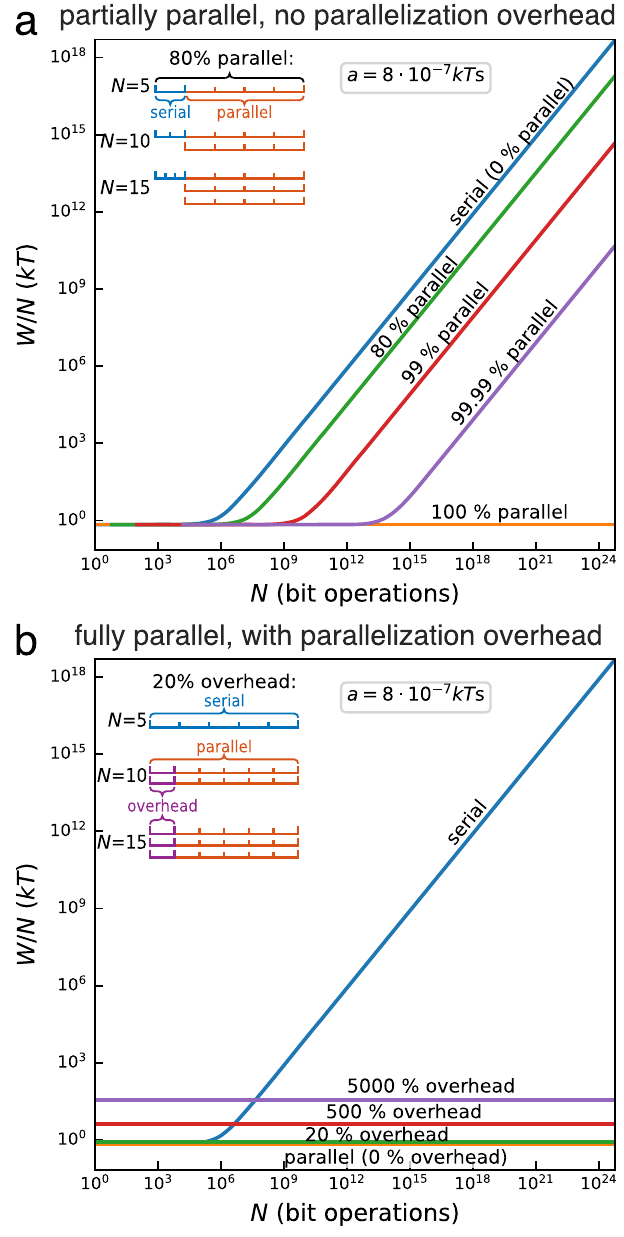
Fig.4|Effectsofnotideallyparallelizableproblems.a Energycostperoperation = N for a partially parallelizable algorithm that has no overhead, Eq. (7). W com tot b Energy cost per operation W ove tot = N for a fully parallel algorithm with linear overhead N ove ( n )= cn , Eq. (9), and c =0 − 5000%. Same parameters as in Fig.